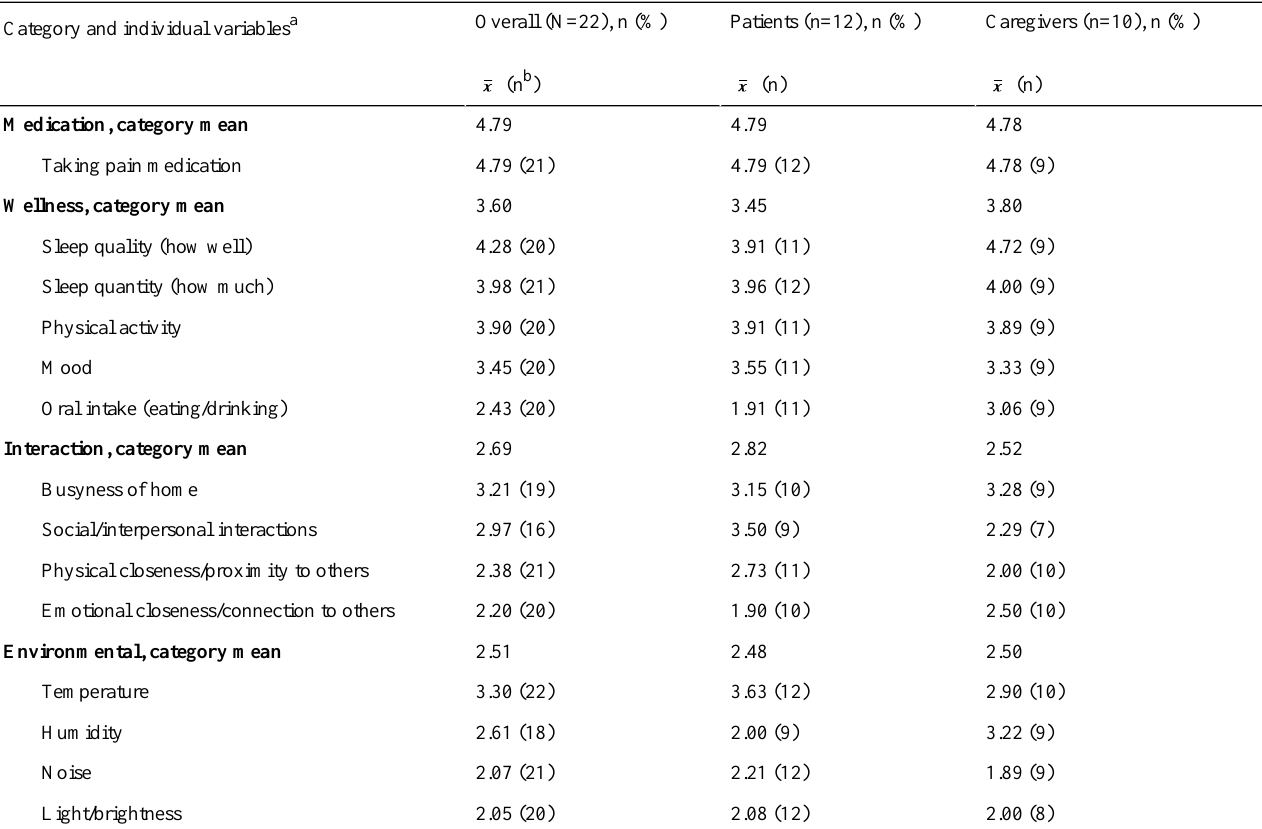
Table 3. Comparison of mean impact scores of factors that influence a patient’s cancer pain at home, by category and individual variable, rated from 0 (no impact) to 5 (highest